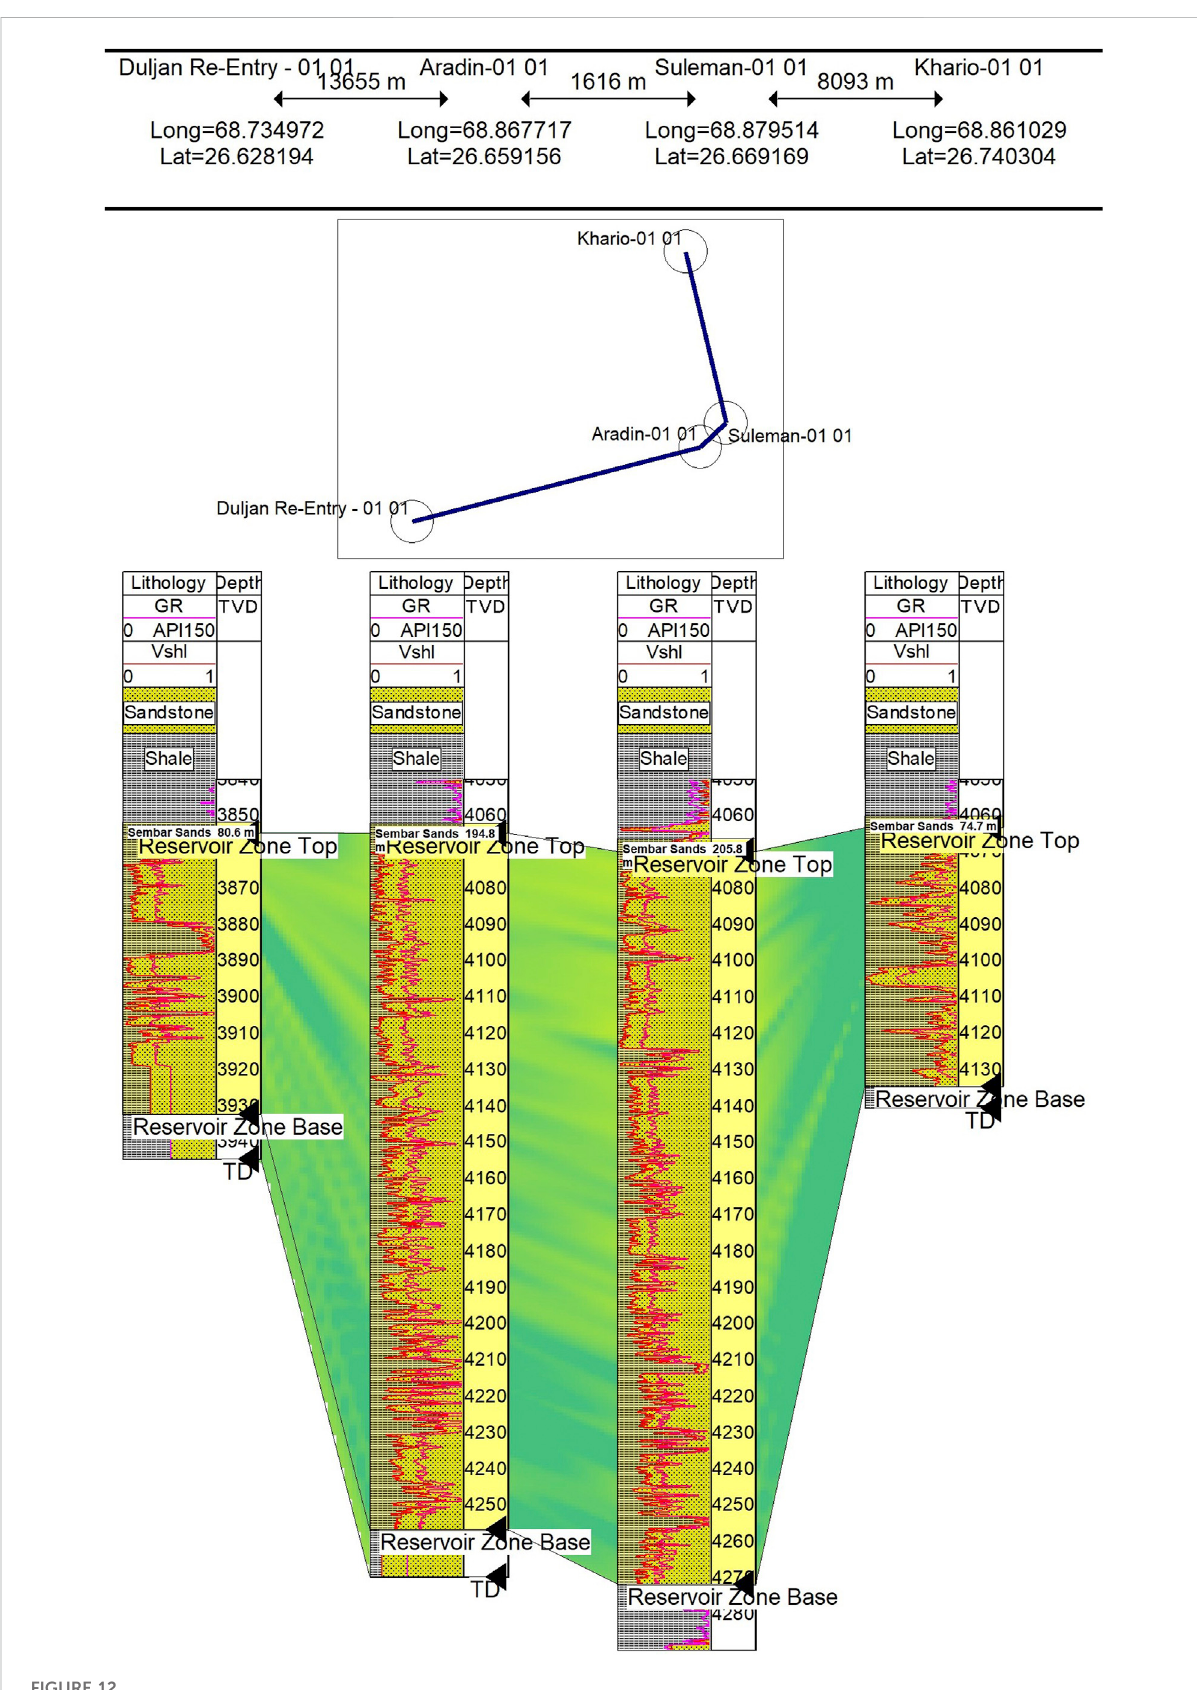
FIGURE 12 Stratigraphic correlation of wells; Duljan Re-Entry-01, Aradin-01, Suleman-01, and Khario-01 from west to